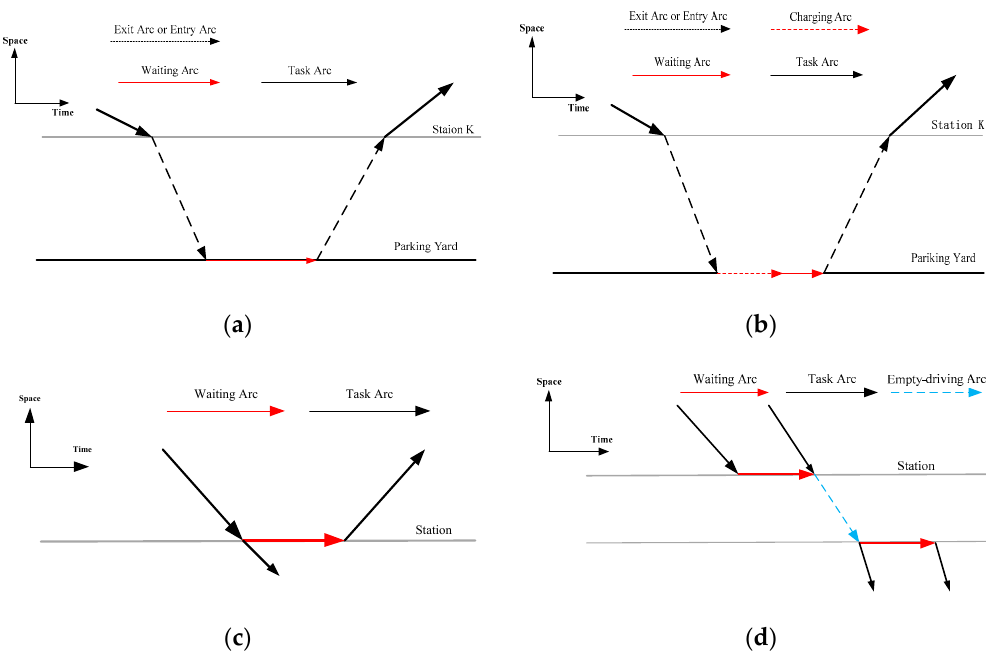
Figure 1. The representation of vehicle operating states in the time-space network. ( a ) The bus returns to the parking yard to wait for next task; ( b ) the pure electric bus gets into the yard to charge; ( c ) the connection of the two tasks at the same site; ( d ) the bus runs two tasks connecting with the empty running arcs.